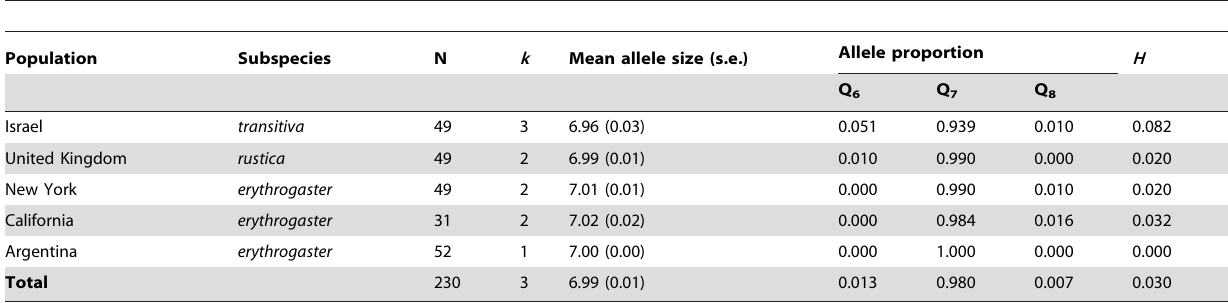
Table 2. Clock poly-Q allele frequencies, number of alleles ( k ), mean allele size (with standard errors) and observed heterozygosities ( H ) for the five Barn Swallow populations used in this study.